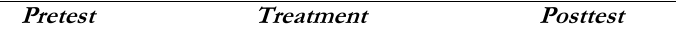
TABLE 1: One Group- Pretest-Posttest